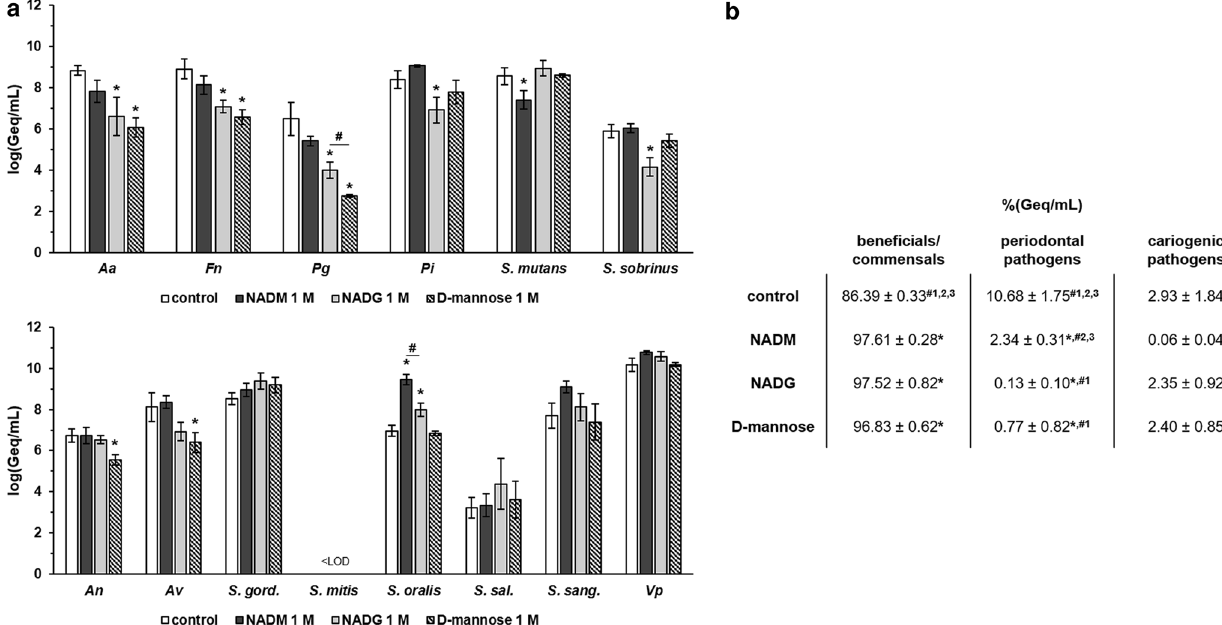
Figure 1. Comparison of the effects of repeated rinsing with NADM, NADG or d-(+)-mannose at 1 M on multi-species biofilm composition. ( Panel a ) Absolute abundances of pathogenic oral species (upper graph) and beneficial/commensal oral species (lower graph) are shown as mean ± SD (n = 3) logarithmic values of the genome equivalents per millilitre (log(Geq/mL)). ( Panel b ) Relative abundances of the different groups (beneficial/commensals, periodontal pathogens, cariogenic pathogens) of bacterial species are shown as mean ± SD (n = 3) percentage of the genome equivalents per millilitre (%(Geq/mL)). All substrates were dissolved in PBS at a concentration of 1 M. Statistically significantly different values when compared to the control (PBS) are marked with ‘ * ’ ( P < 0.05 ANOVA + Dunnett’s correction for simultaneous hypothesis testing), statistically significantly different values between two treatment conditions (NADM = condition 1, NADG = condition 2, d-(+)-mannose = condition 3), which were only considered to be relevant if each condition was also significantly different from the control condition, are marked with ‘ # ’ ( P < 0.05, ANOVA + Tukey’s correction for simultaneous hypothesis testing for comparisons between 3 substrates, unpaired two-tailed t-test for comparisons between 2 substrates). Aa : A. actinomycetemcomitans ; Fn : F. nucleatum ; Pg : P. gingivalis ; Pi : P. intermedia ; An : A. naeslundii ; Av : A. viscosus ; S. gord. : S. gordonii ; S. sal. : S. salivarius ; S. sang. : S. sanguinis ; Vp : V. parvula ; LOD: limit of detection (= 2.65 log(Geq/mL)); NADM: N -acetyl-d-mannosamine; NADG: N -acetyl-d- glucosamine were analysed. Significant differences between two substrate conditions were only considered relevant if they were each also significantly different from the control condition. At a substrate concentration of 1 M (Fig. 3, Supplementary Table S3) and when compared to the control, lactate production was unaffected whereas formate production was significantly increased for NADM (791.9 ± 138.27 vs. 384.42 ± 19.24 mg/L). Acetate production was significantly decreased for NADM and d-(+)-mannose (3084 ± 174 and 1934 ± 56 mg/L, respectively, vs. 3779 ± 305 mg/L). Significantly increased propionate production was observed for NADG and d-(+)-mannose (2750 ± 40 and 2821 ± 127 mg/L, respectively, vs. 2094 ± 132 mg/L). Finally, butyrate production was signifi- cantly decreased for NADM, NADG and d-(+)-mannose (541 ± 52, 1255 ± 51 and 85 ± 15 mg/L, respectively, vs. 1870 ± 93 mg/L). In terms of relevant significant differences between substrate conditions, an increase in acetate production was observed for NADM compared to d-(+)-mannose (3084 ± 174 vs. 1934 ± 56 mg/L). Butyrate production was significantly lower for NADM and d-(+)-mannose compared to NADG (541 ± 52 and 85 ± 15 vs. 1255 ± 51 mg/L), with in addition d-(+)-mannose yielding lower butyrate production in comparison with NADM (541 ± 52 vs. 85 ± 15 mg/L). No significant differences could be observed for a substrate concentration of ~ 0.05 M (1% (w/v) ), both versus the control and when comparing between substrates (Fig. 3, Supplementary Table S3).